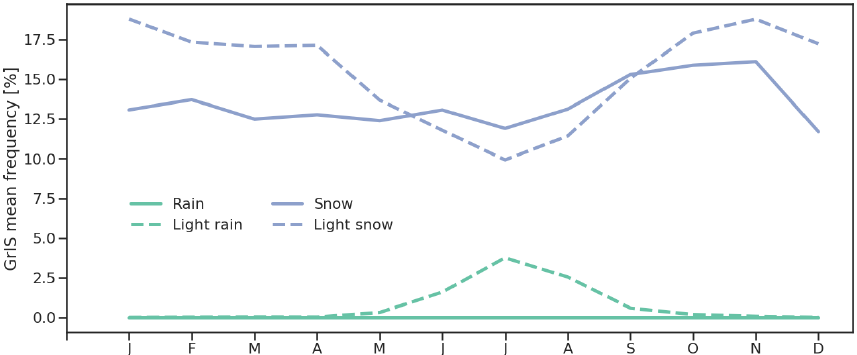
Figure 6. Present-day Greenland Ice Sheet averaged snowfall and light snowfall (blue: solid, dashed) and rainfall and light rainfall (green: solid, dashed) frequency as simulated by CESM (2006–2020).